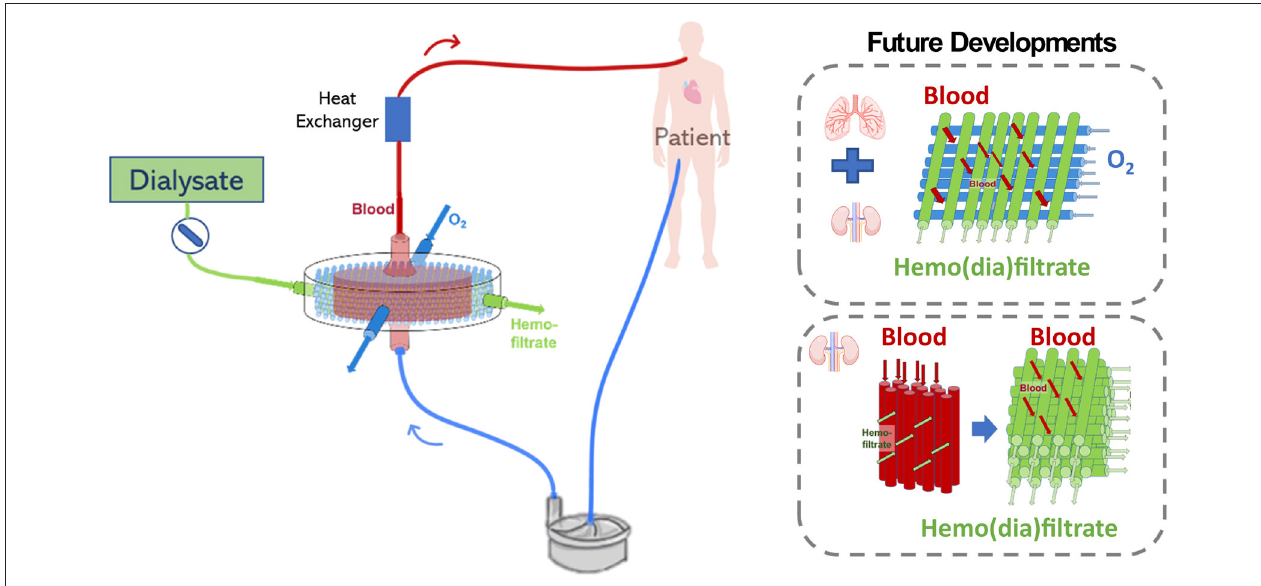
FIGURE 10 | Possible challenges related to the development of an extracorporeal lung and kidney support device may include the configuration which oxygenation and hemofiltration fiber will be combined, the filtration mode, and future device